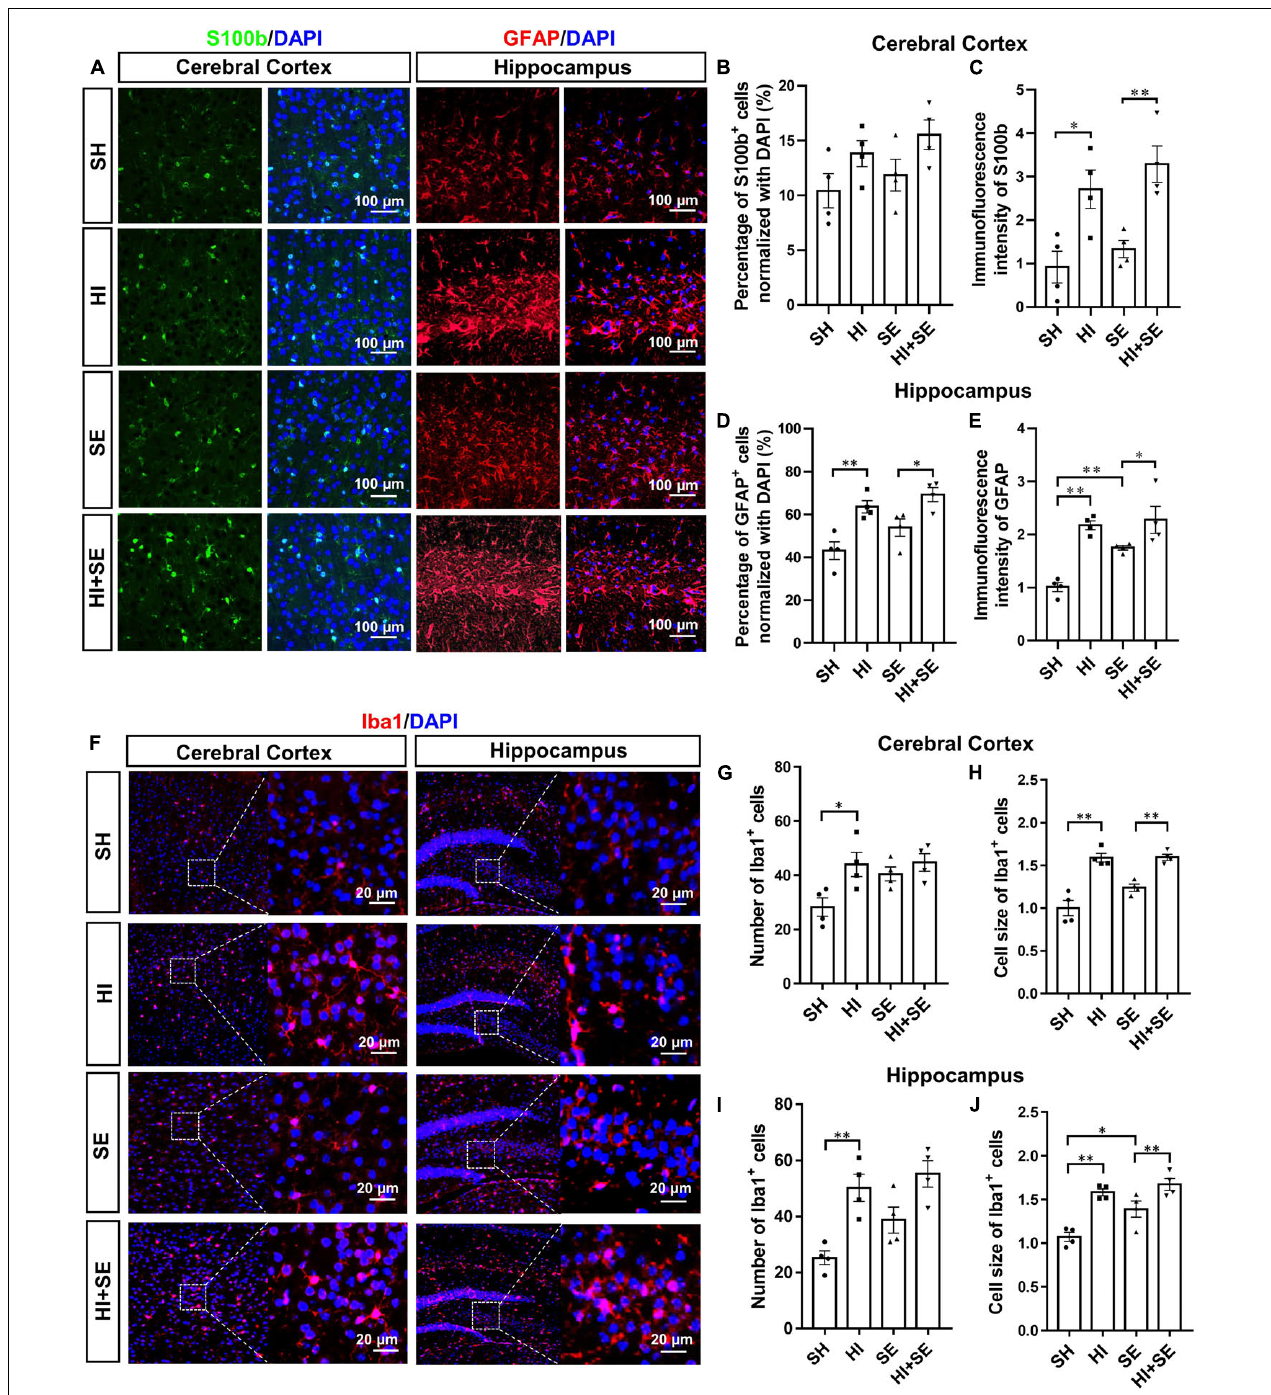
FIGURE 5 | Glial cell activation induced by HI injury and maternal SE. Representative images of immunofluorescence staining of S100b in the cerebral cortex and GFAP in the hippocampus (A) . The percentage of S100b immunoreactive (S100b + ) cells (B) and immunofluorescence intensity of S100b (C) in the cerebral cortex. The percentage of GFAP immunoreactive (GFAP + ) cells (D) and immunofluorescence intensity of GFAP (E) in the hippocampus. Representative images of immunofluorescence staining of Iba1 in cerebral cortex and hippocampus (F) . The number and cell size of Iba1 immunoreactive (Iba1 + ) cells in the cerebral cortex (G,H) and hippocampus (I,J) . Results are presented as mean ± SEM. ∗ P < 0.05, ∗∗ P < 0.01, n = 4, analyzed by two-way ANOVA followed by post hoc Turkey tests. SH, from sham exposed dams with sham surgery; HI, hypoxic-ischemic injury; SE, from smoke exposed dams with sham surgery; HI + SE, from smoke exposed dams with hypoxic-ischemic